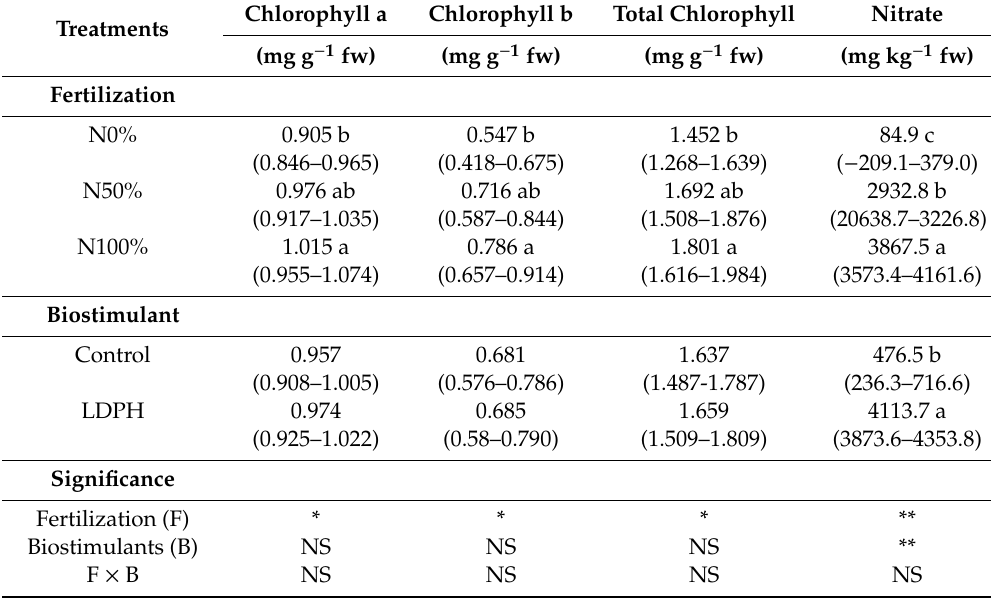
Table 3. Chlorophyll a and b, total chlorophyll and nitrate content of baby spinach plants as a ff ected biostimulant application (control and LDPH: Legume-derived protein